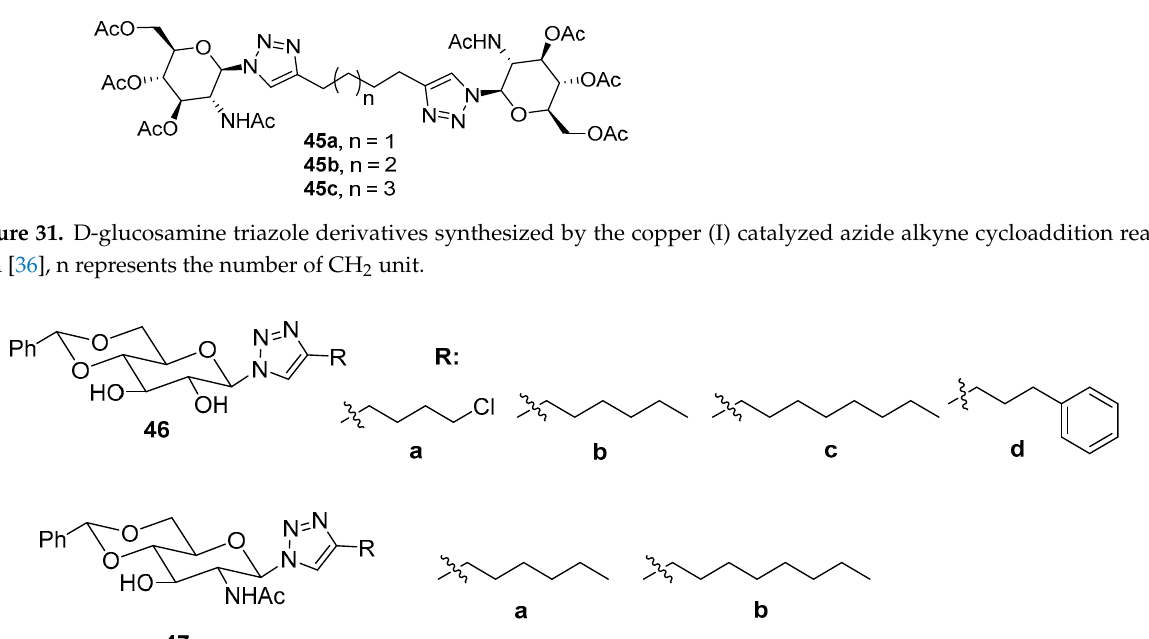
Figure 31. D-glucosamine triazole derivatives synthesized by the copper (I) catalyzed azide alkyne cycloaddition reaction [36], n represents the number of CH 2 unit.